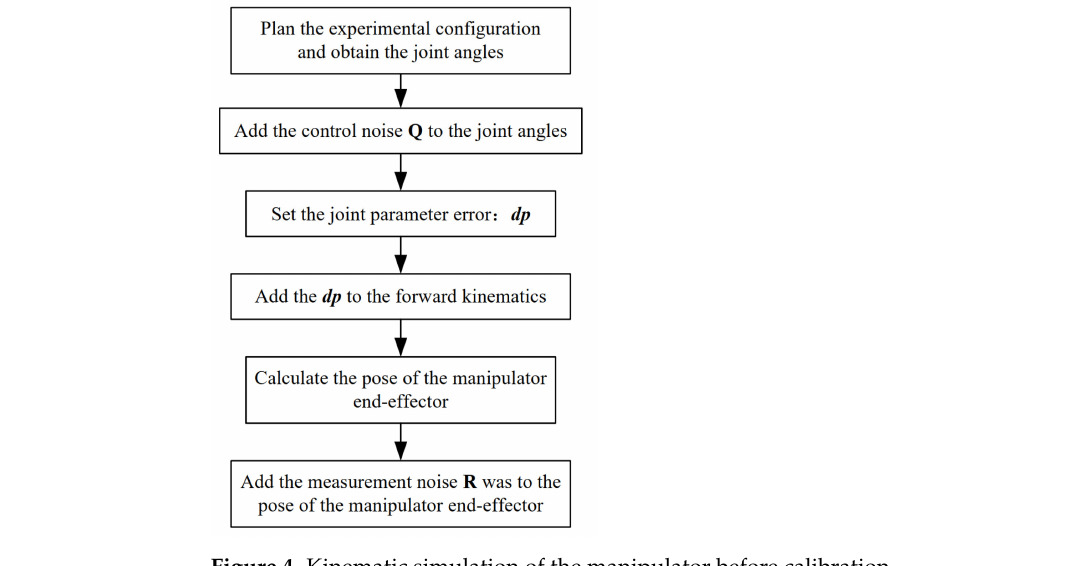
Figure 4. Kinematic simulation of the manipulator before calibration. Table 3. Error preset values of joint kinematic parameters.